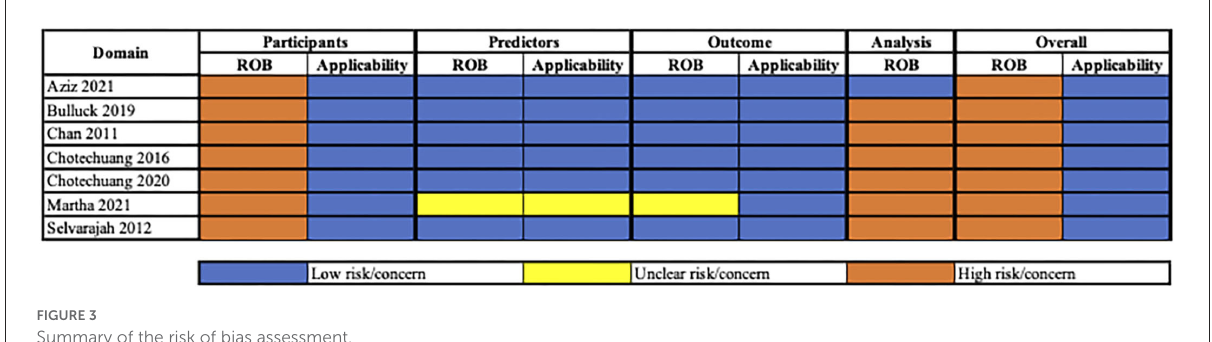
FIGURE3 Summary of the risk of bias